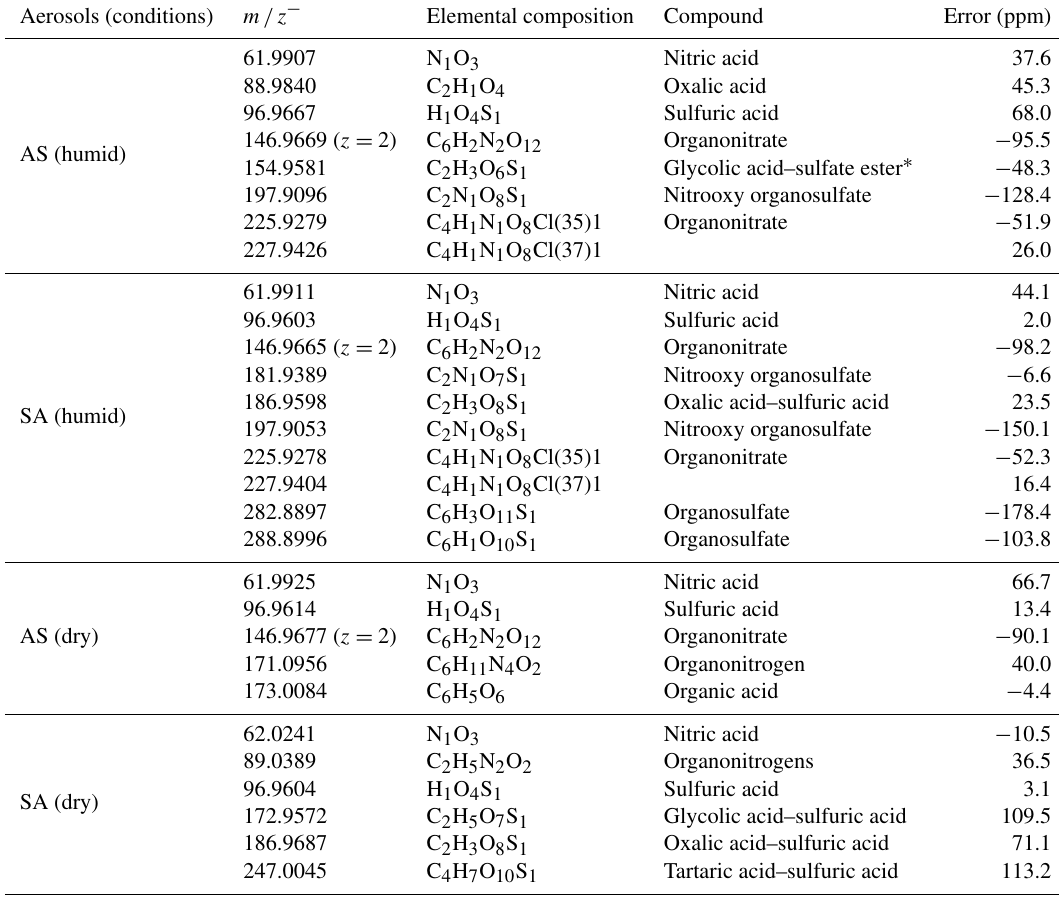
Table 1. Elemental compositions of organic–inorganic compounds at 180min irradiation time (UPLC-Q-TOF-MS negative-mode analysis). Aerosols (conditions) m / z − Elemental